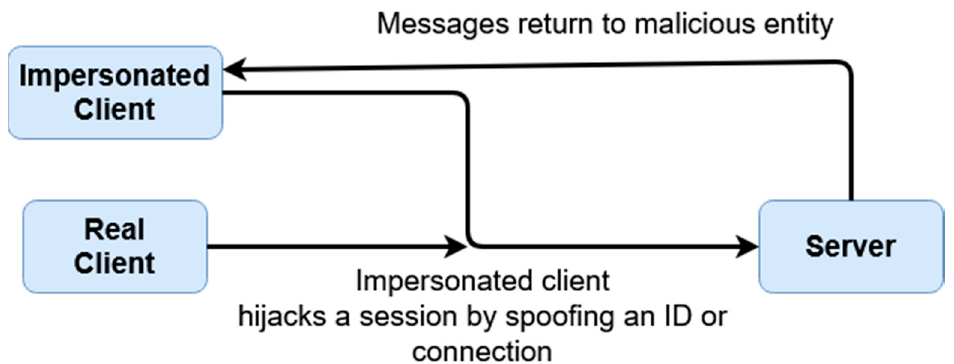
Figure 10. A masquerade attack under a normal authentication system.